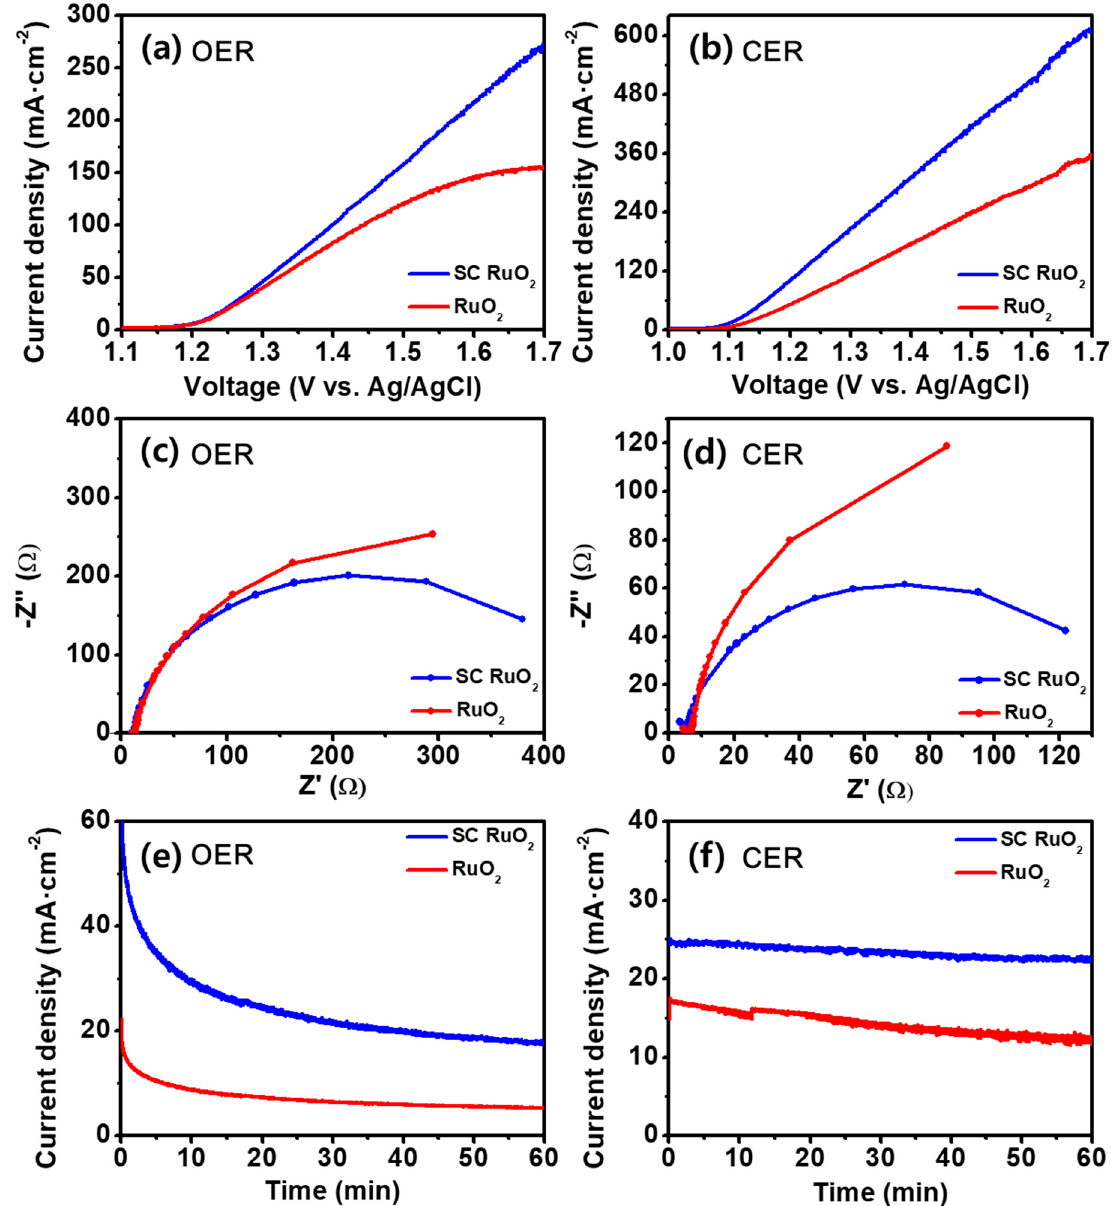
Figure 3. (a, c and e) OER in a 0.5 M H 2 SO 4 solution and (b, d and f) CER in a 5 M NaCl + 0.01 M HCl solution over SC RuO 2 and RuO 2 . (a, b) LSV curves at a scan rate of 10mV s -1 . Nyquist plots at a a constant voltage of ( c ) 1.2 V and ( d ) 1.1 V at frequencies from 100 kHz to 0.1 Hz with an amplitude of constant voltage of (c) 1.2 V and (d) 1.1 V at frequencies from 100 kHz to 0.1 Hz with an amplitude of 5 mV. CA curves at a constant voltage of ( e ) 1.25 V and ( f ) 1.15 5 mV. CA curves at a constant voltage of (e) 1.25 V and (f) 1.15 V.